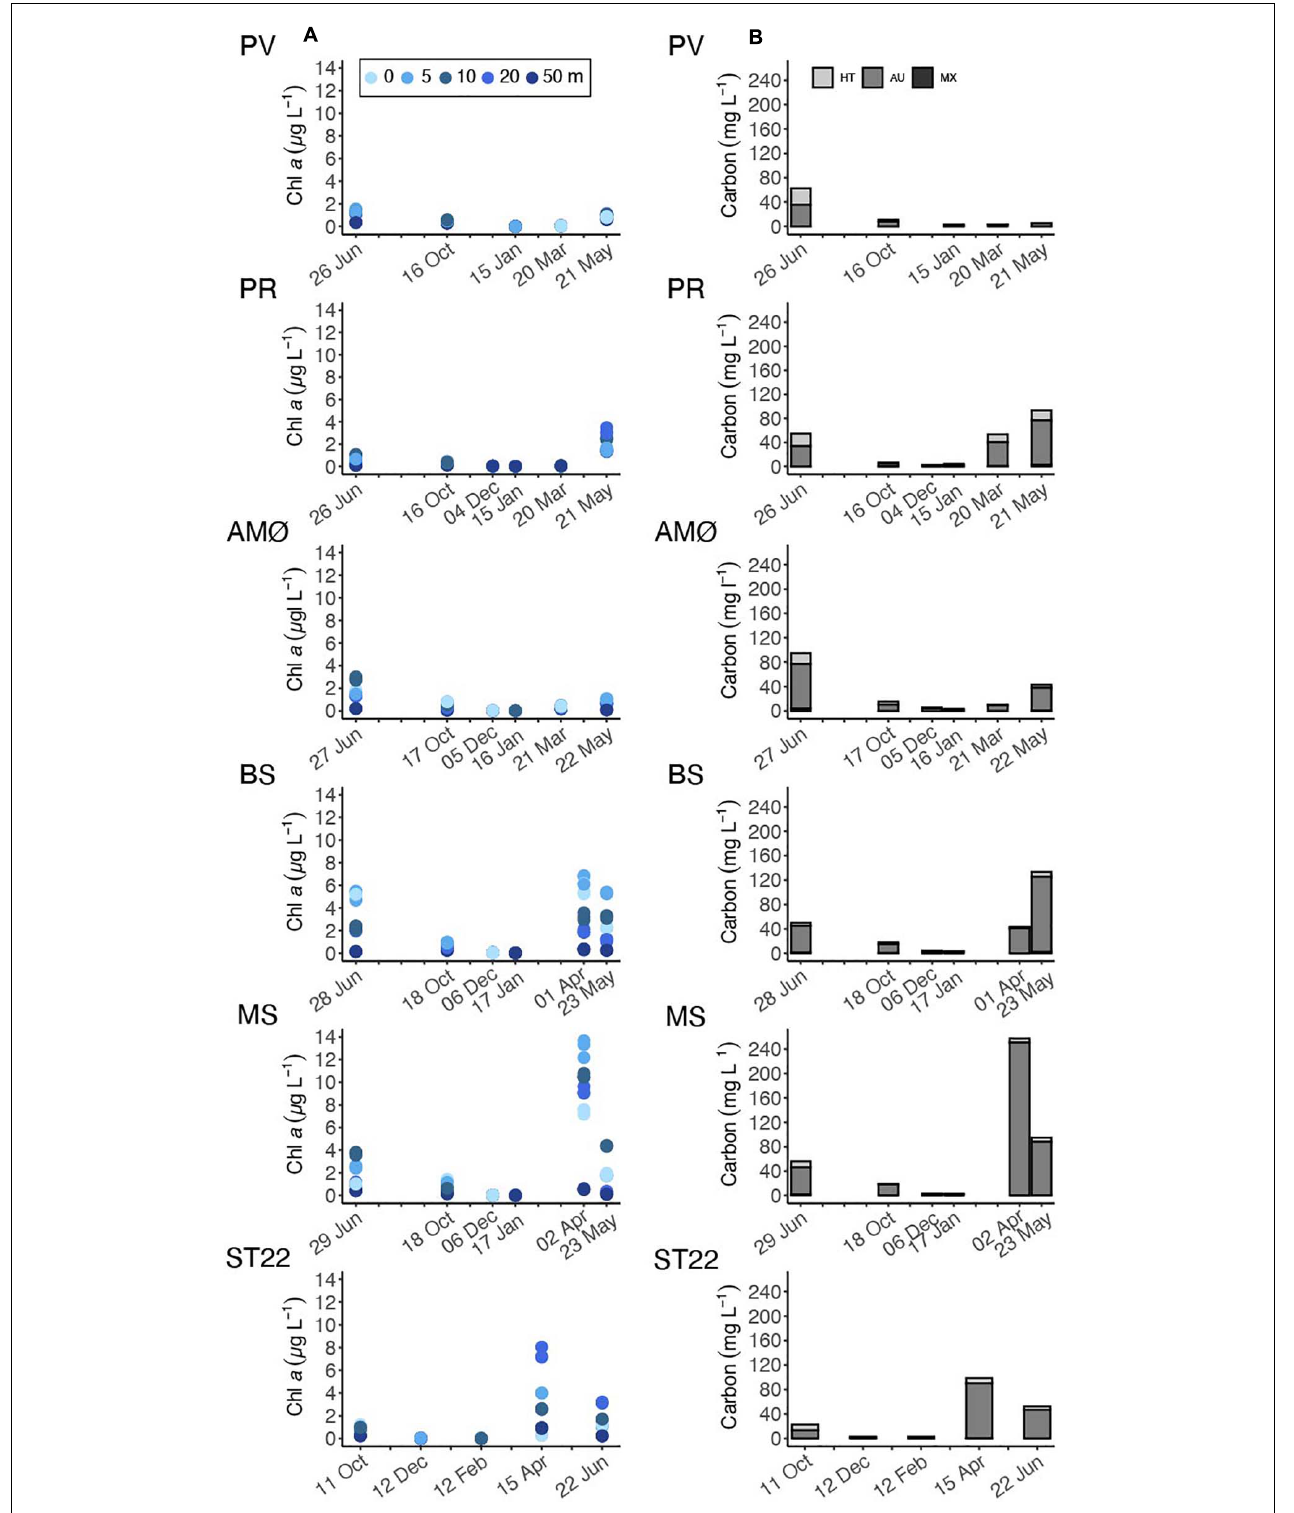
FIGURE 3 | Time series of (A) chl a concentration at discrete sampling depths of 0, 5, 10, 20, and 50 m. (B) Phytoplankton biomass estimated as carbon content from cellular biovolume and cellular carbon content and divided into trophic types: heterotrophic (HT), autotrophic (AU) and, mixotrophic (MX). Note different sampling months at